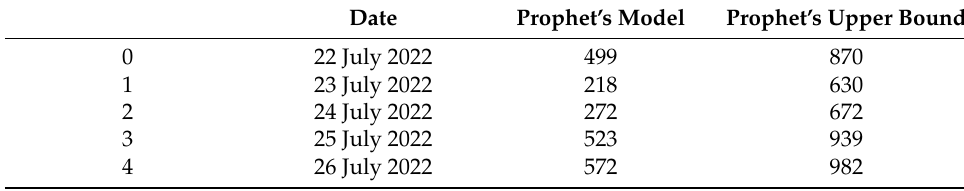
Table 9. Prophet model confirmed case prediction for five